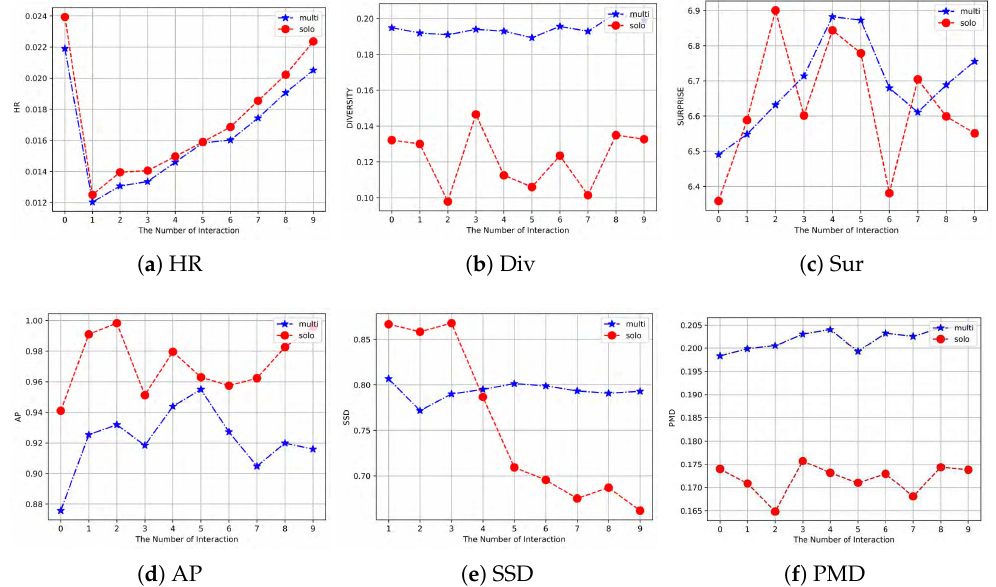
Figure 7. The recommendation performance of the two algorithms on six metrics when performing interactions in the CD dataset.